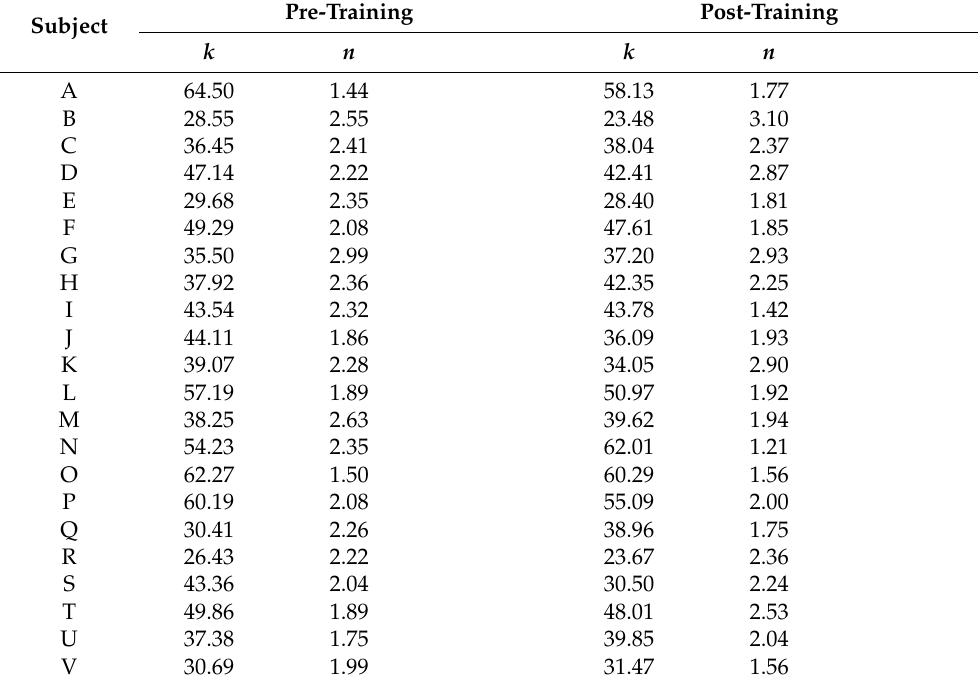
Table 2. Values of the least-square fitted parameters describing the curves of the active drag depen- dent on swimming speed ( D = k × v n